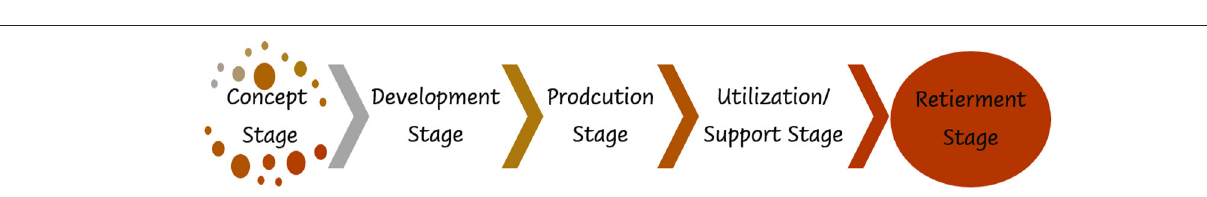
FIGURE 9 | Complete architecture of proposed system of interest (SOI).